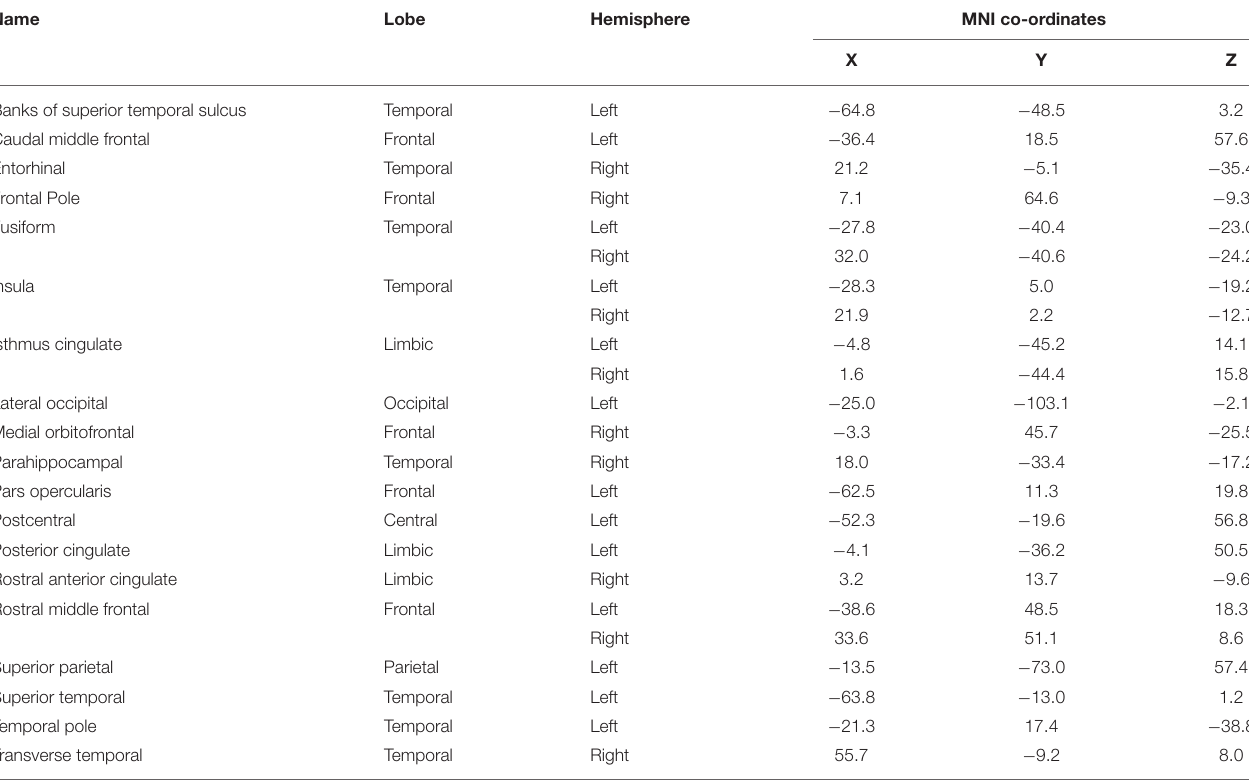
TABLE 2 | Name and description of the cortical regions that changed linearly across the intervention and frequency